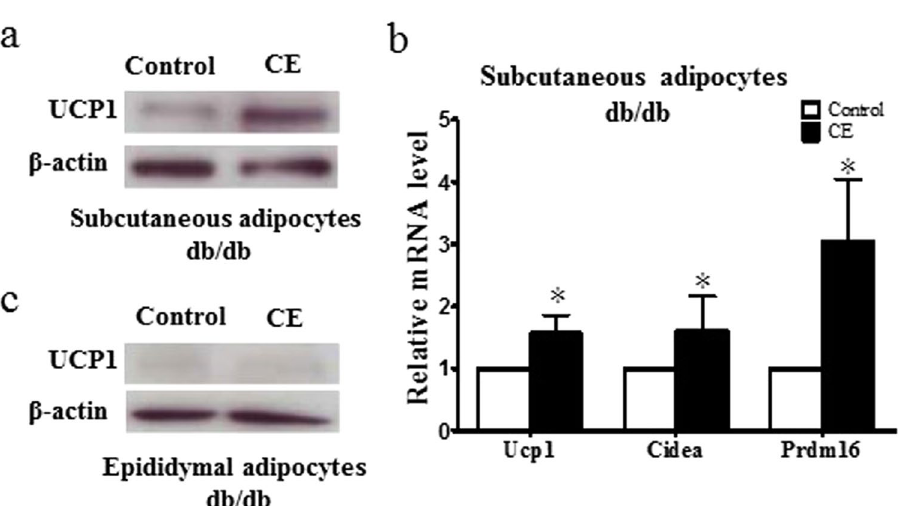
Figure 5. Expressions of ( a ) UCP1 protein and ( b ) brown adipocyte marker genes in subcutaneous adipocytes isolated from db/db mice. ( c ) Expression of UCP1 protein in epididymal adipocytes isolated from db/db mice. CE, cinnamon extract (80 µ g/ml). Ucp1, uncoupling protein 1; cidea, cell death-inducing DFFA-like effector A; Prdm16, PR domain containing 16. * p < 0.05, n = 3 individual